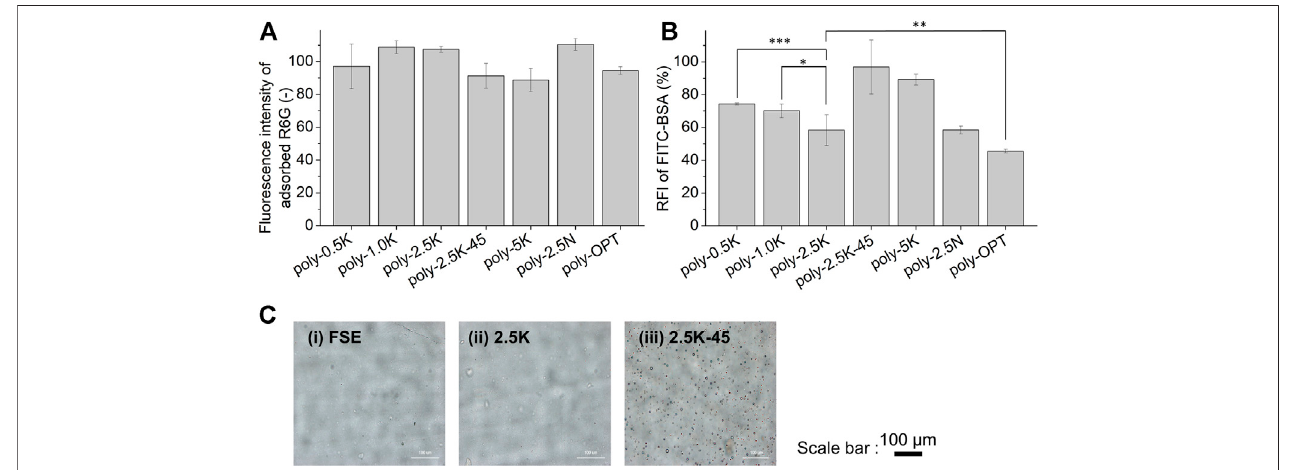
FIGURE 4 | Characterizations of the polymer fi lm coated under different conditions ( Table 1 ). Fluorescence intensity of the adsorbed R6G on the polymer fi lm (A) ; Relative fl uorescenceintensityofadsorbedFITC-BSAonthepolymer-coatedsurface. (B) Resultsarepresentedasmean±SD( n =9). (C) Opticalmicroscopeimagesfor surface morphology of SEs (i) without treatment, (ii) treated with 2.5 K, (iii) treated with 2.5K – 45. * , **, and *** indicate p < 0.05, p < 0.01, and p < 0.001, respectively.